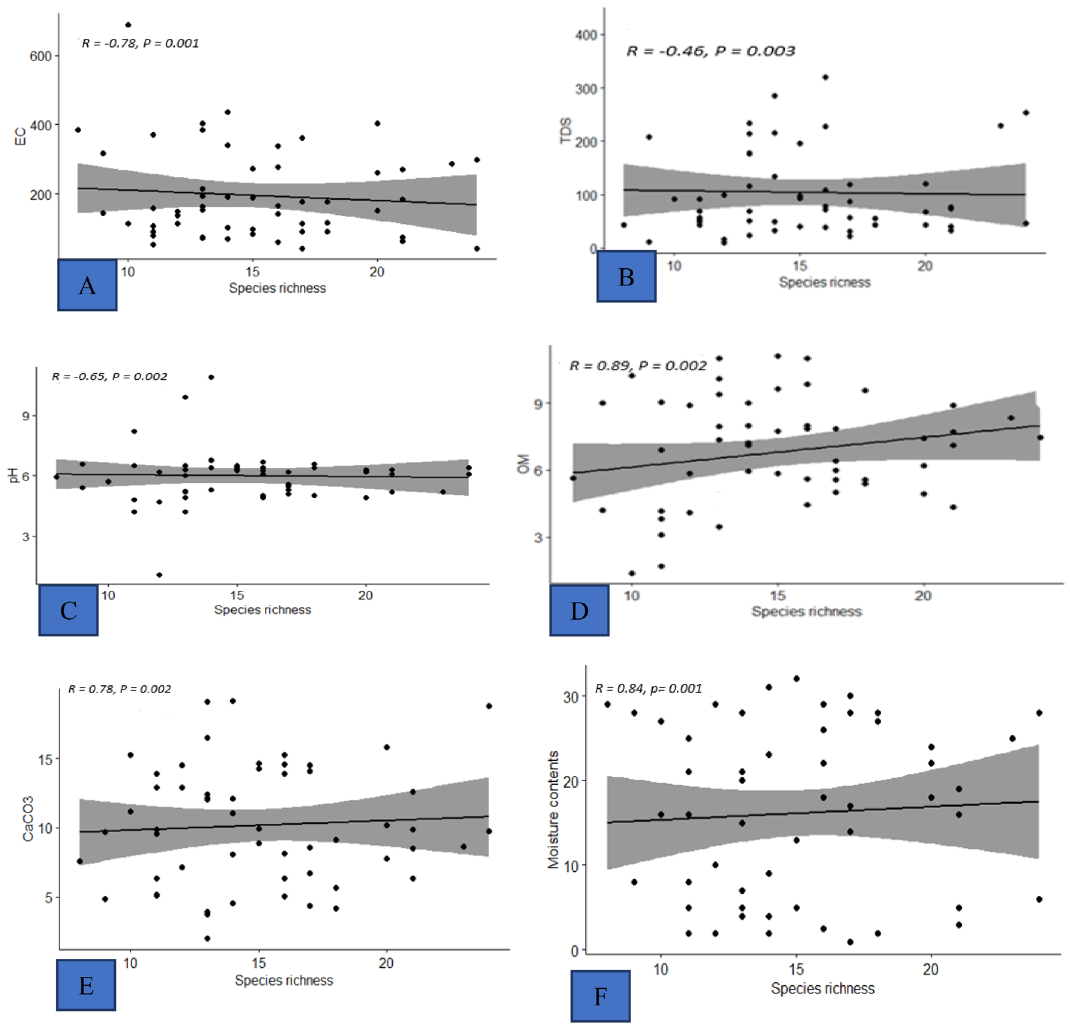
Figure 3. Regression analysis between soil variables and plant species richness. Impact of soil ( A ) EC ( B ) TDS ( C ) pH ( D ) OM ( E ) CaCO 3 ( F ) moisture contents with species richness . Here, OM organic matter, EC electrical conductivity, TDS total dissolved solvents.